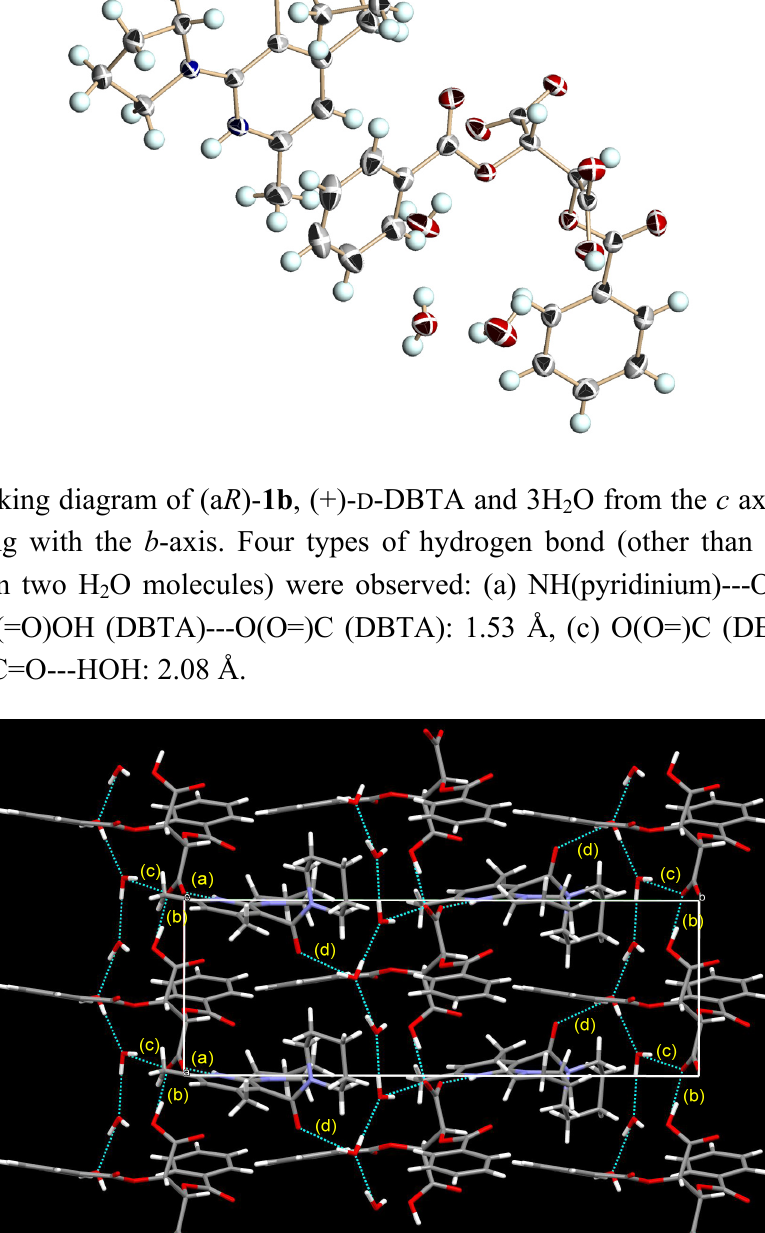
Figure 7. Perspective view of the chiral salt composed of (a R )- 1b , (+)- D -DBTA and 3H The ellipsoids are presented as 40% probability. A hydrogen bond between NH (pyridinium) and O C ( D -DBTA) was observed with a distance of 2.01 Å. 2